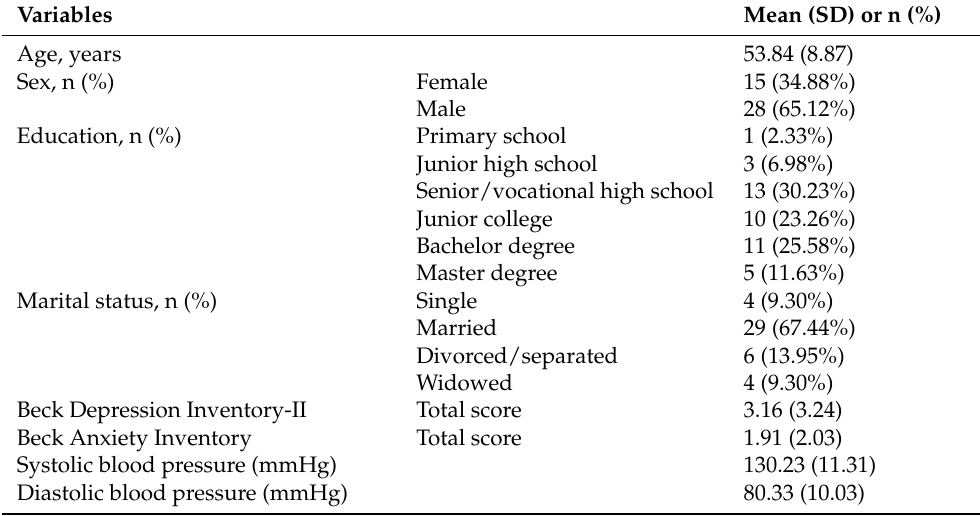
Table 1. The demographic data, psychological questionnaires, and blood pressure (n =